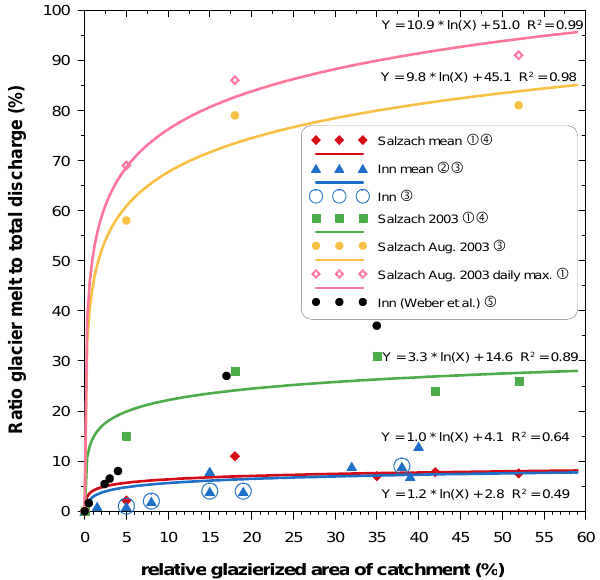
Fig. 1. Maximum daily, August 2003, 2003 annual and long-term mean relative glacier melt contribution vs. relative glacierization of the Inn and Salzach basin. Displayed data were compiled from dif- ferent published studies. Encircled numbers in the legend indicate study references in Table